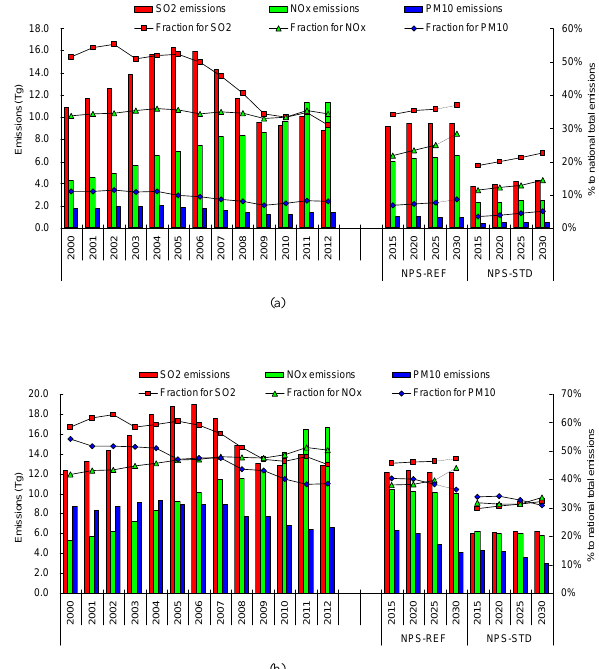
Figure 5. China’s annual emissions (left scale) and fractions of to- tal national emissions (right scale) of given sources ( (a) CPP and (b) CPP + CEM + ISP) for 2000–2012 and the projected values